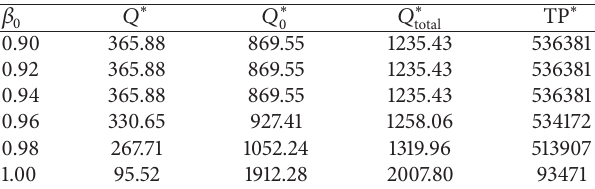
Table 4: Effect of changing 𝛽 0 on the optimal